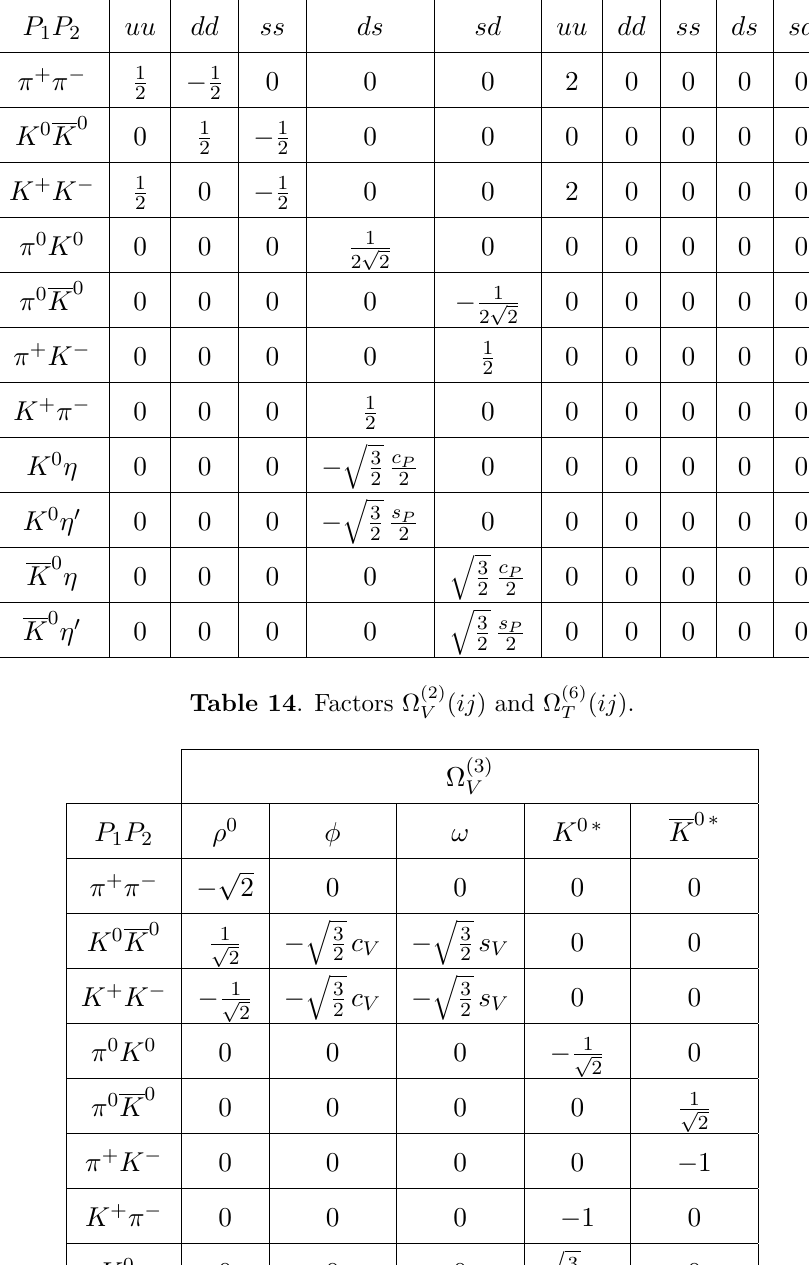
Table 15 . Factors Ω (3)